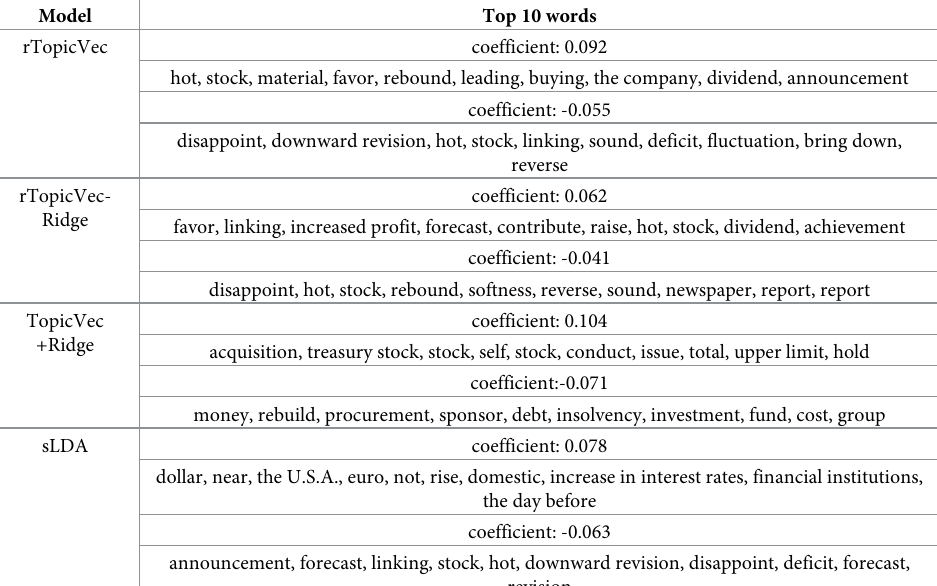
Table 3. Top 10 words of two topics with highest absolute values of regression coefficients.